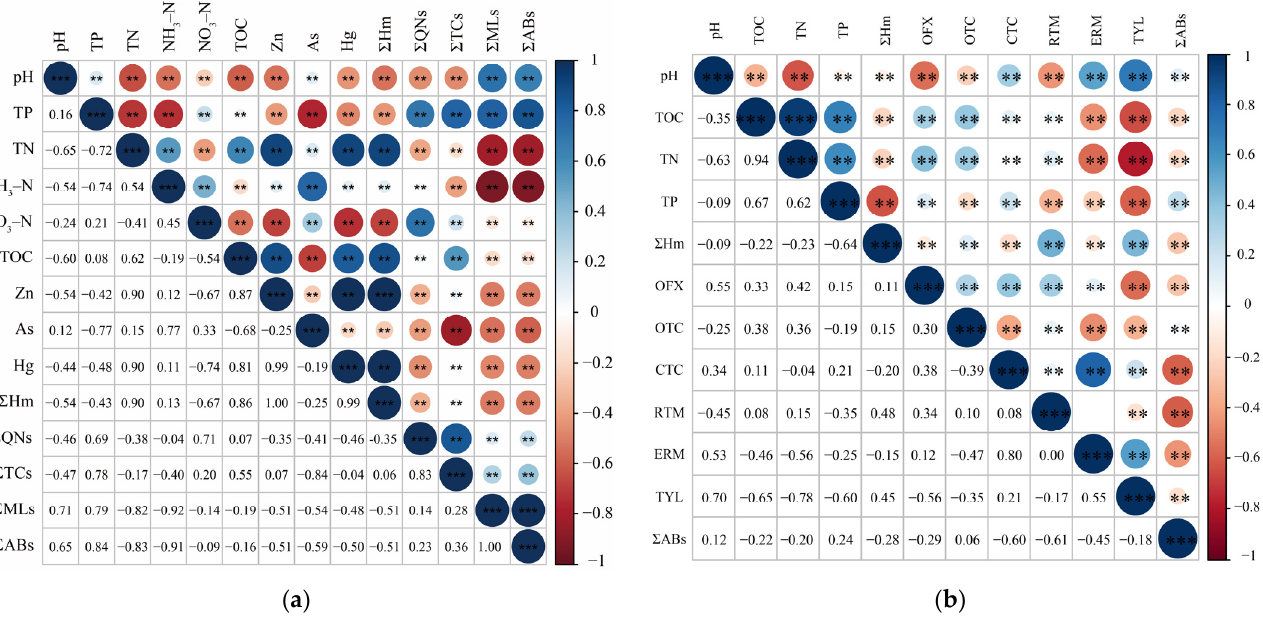
Figure 6. Spearman correlation between antibiotics and ( a ) water or ( b ) sediment properties. Hm included Cr, Cd, Cu, Hg, Ni, Pb, Zn, and As. ** p < 0.01, *** p < 0.001.